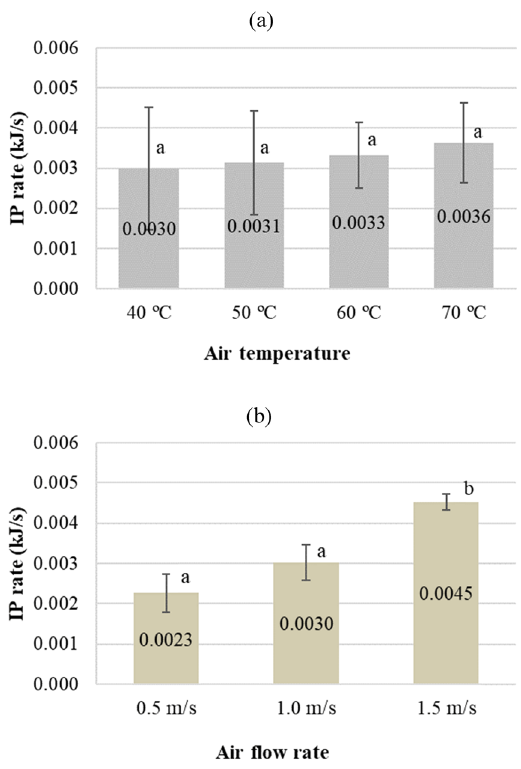
Figure 7: Mean values of exergy IP rate for the drying of potato slices for: ( a ) fi xed temperature or ( b ) fi xed fl ow rate ( bars with the same letter correspond to the values not signi fi cantly di ff erent according to ANOVA and Tukey ’ s post hoc test with p < 0.005 )